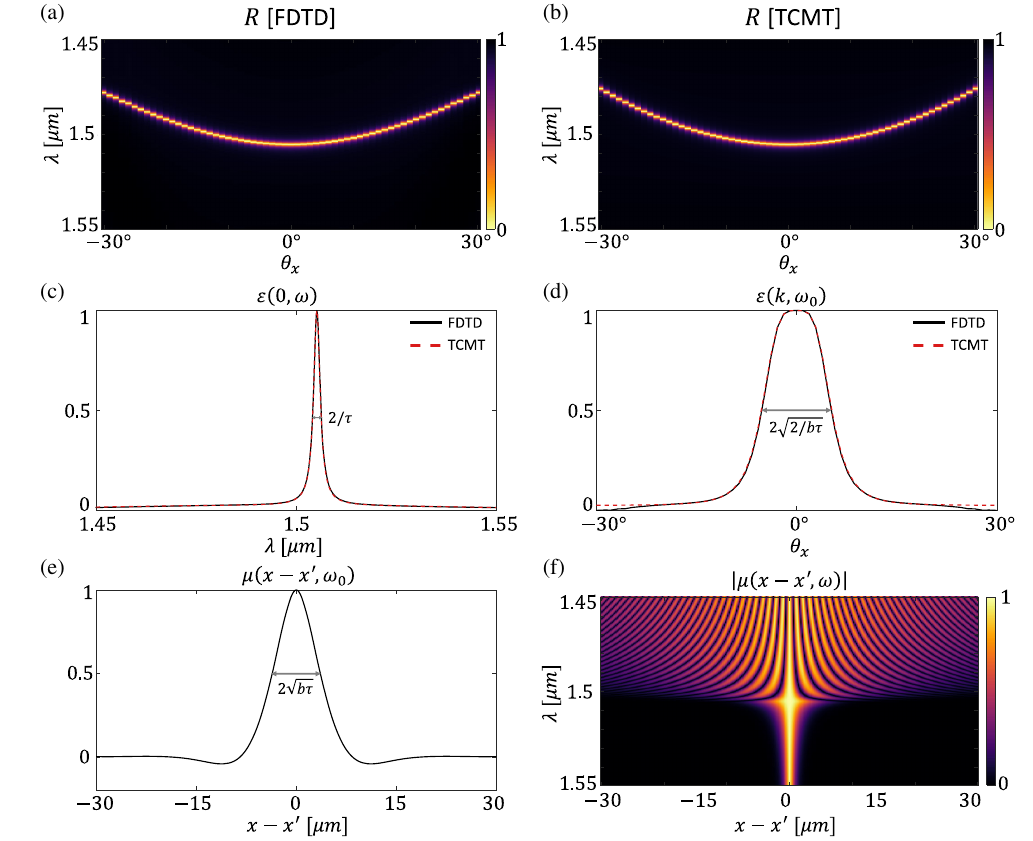
FIG. 4. Temporal and spatial coherence of a QBIC thermal metasurface. (a),(b) Reflectance for x -polarized light near a critically coupled QBIC calculated based on FDTD [(a), reproduced from Fig. 3(d)] and TCMT (b). (c) Emissivity at normal incidence, with the linewidth inversely related to the temporal coherence. (d) Emissivity profile at the band-edge frequency, with the angular width given by the spatial coherence. (e) Spectral degree of coherence at the band-edge frequency, with the linewidth characterizing the spatial coherence of the emission. (f) Magnitude of the spectral degree of coherence mapped in the space-frequency